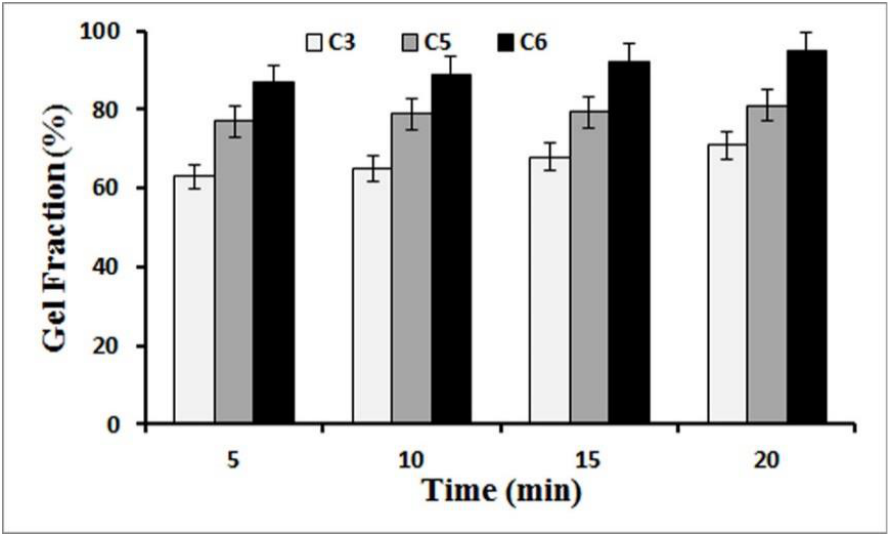
Figure 3. Changes in gel fraction at different times.